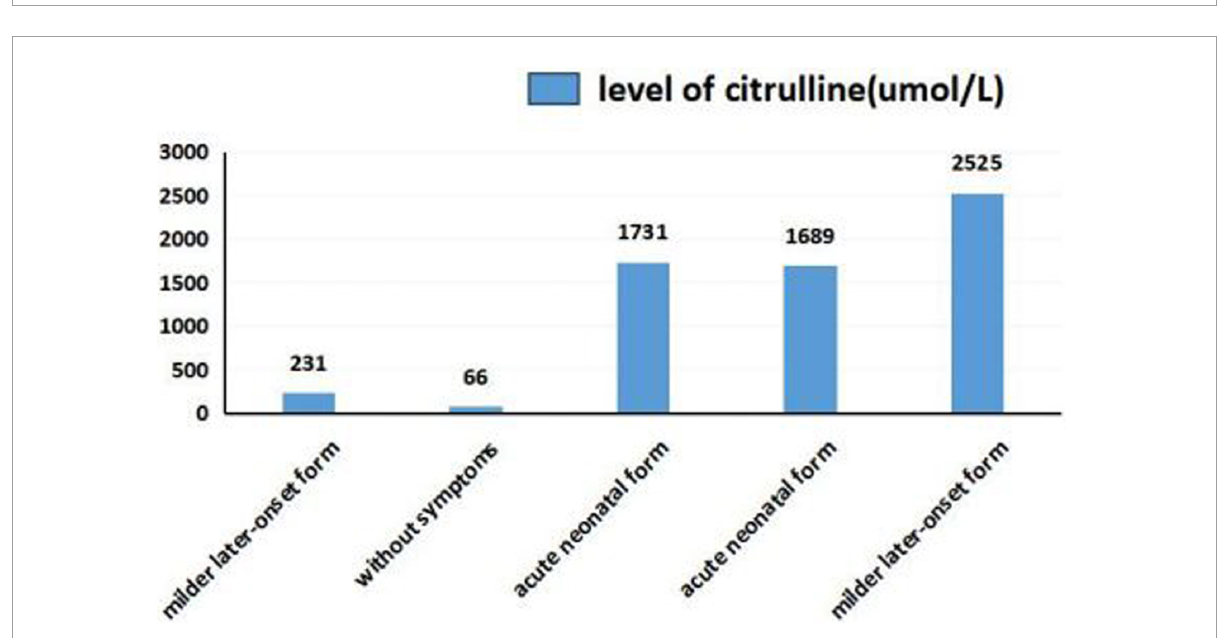
FIGURE6 Citrulline levels in different clinical